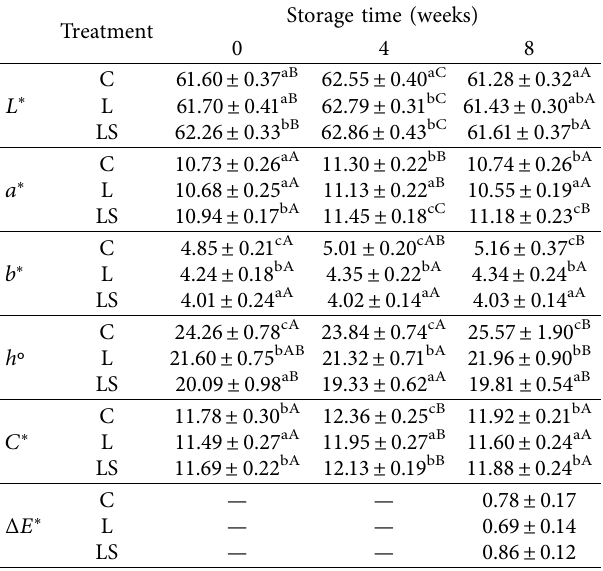
0.86 ± 0.12 a–c Means in the same columns with different superscript small letters differ significantly ( P ≤ 0 . 05). A–C Means in the same row with different super- script capital letters differ significantly ( P ≤ 0 . 05). C: control treatment, quantity added NaNO 2 100mg/kg; L: quantity added NaNO 2